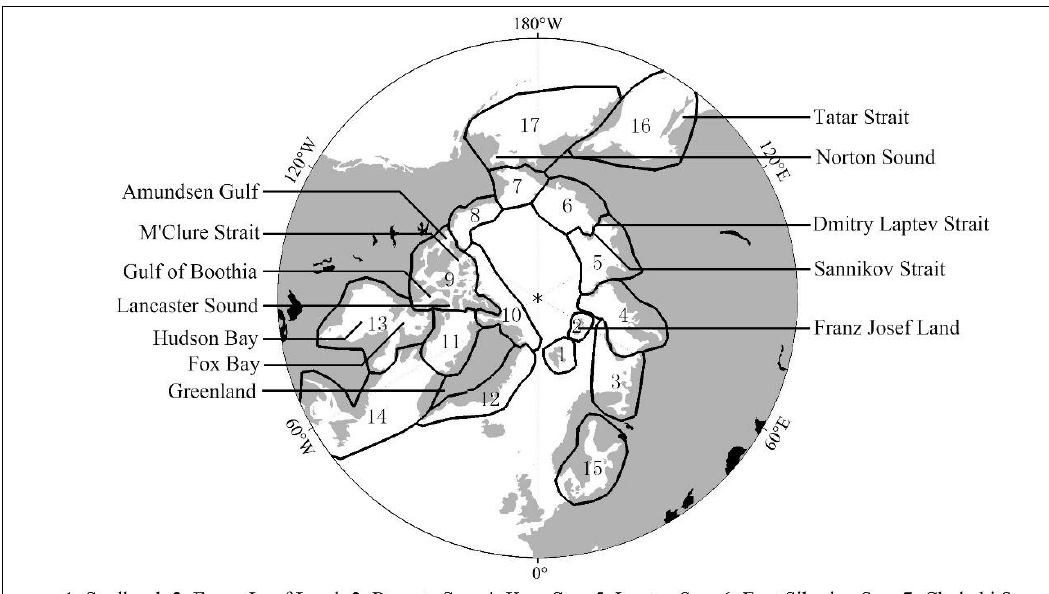
Figure 1. Map showing the locations mentioned in this paper. The criteria for the 17 subregions is from Yu et al.